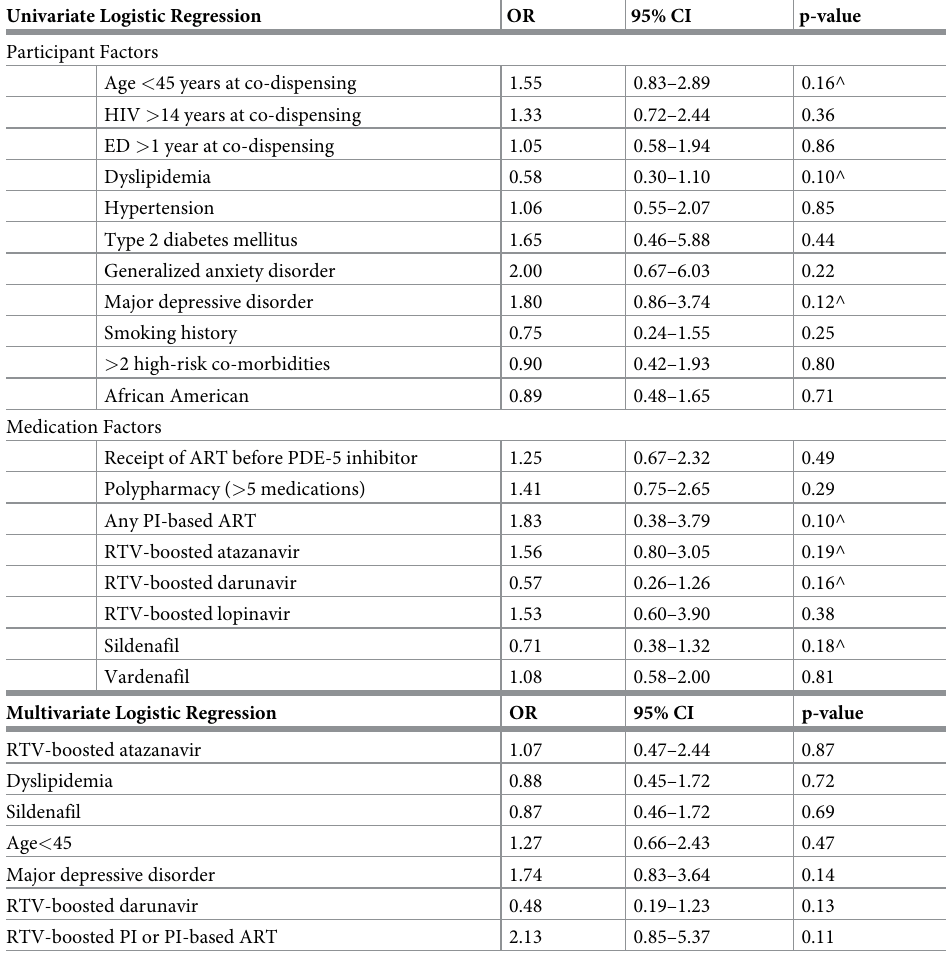
Table 2. Factors associated with PDE-5 inhibitor-mediated drug-drug interactions. Univariate Logistic Regression